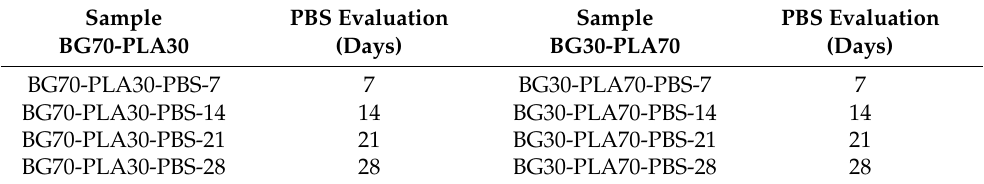
Table 2. Identification of samples evaluated in